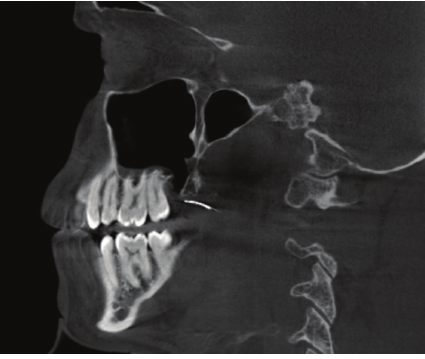
Figure 4: Intraoperative